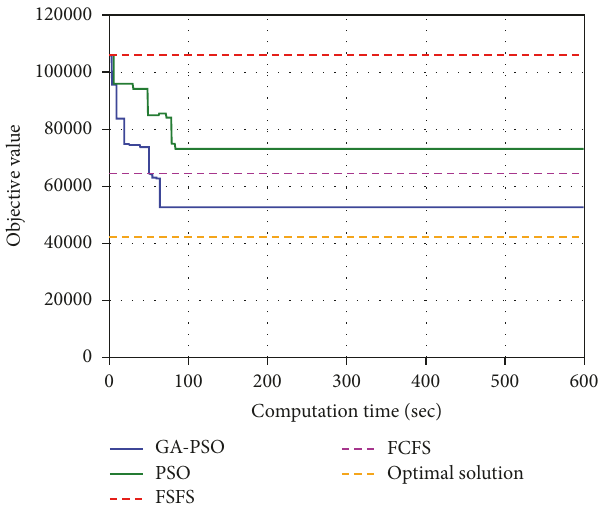
Figure 9: Comparison of different